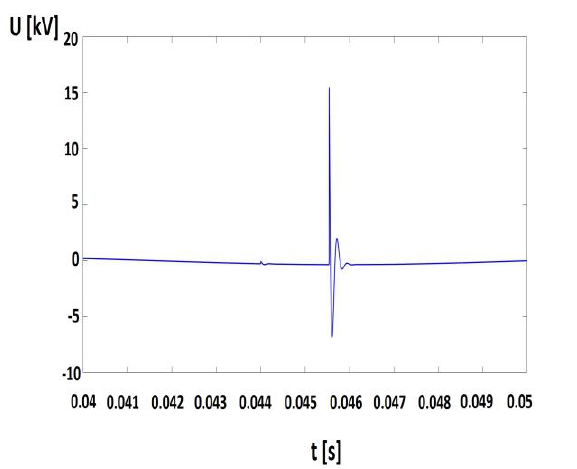
Fig. 2. Current waveform with a surge disturbance.